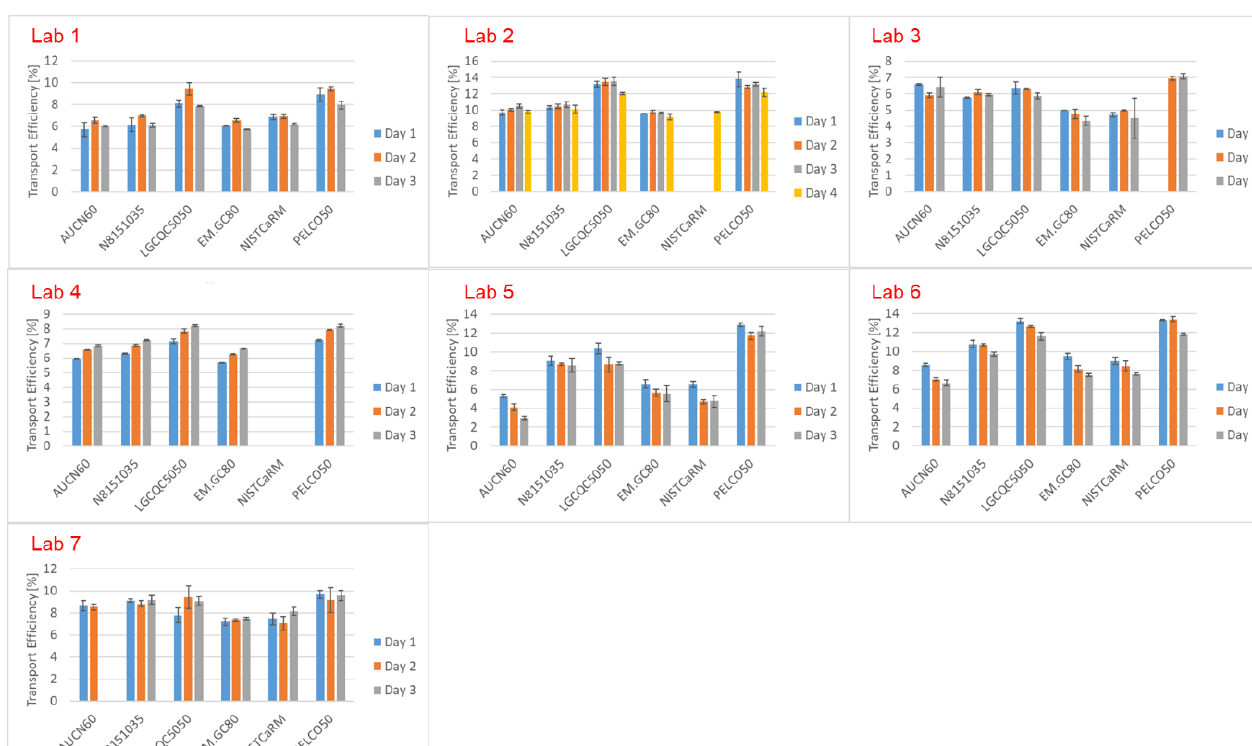
Figure 7. Transport efficiencies based on measured particle frequency (TEF) determined on different days.